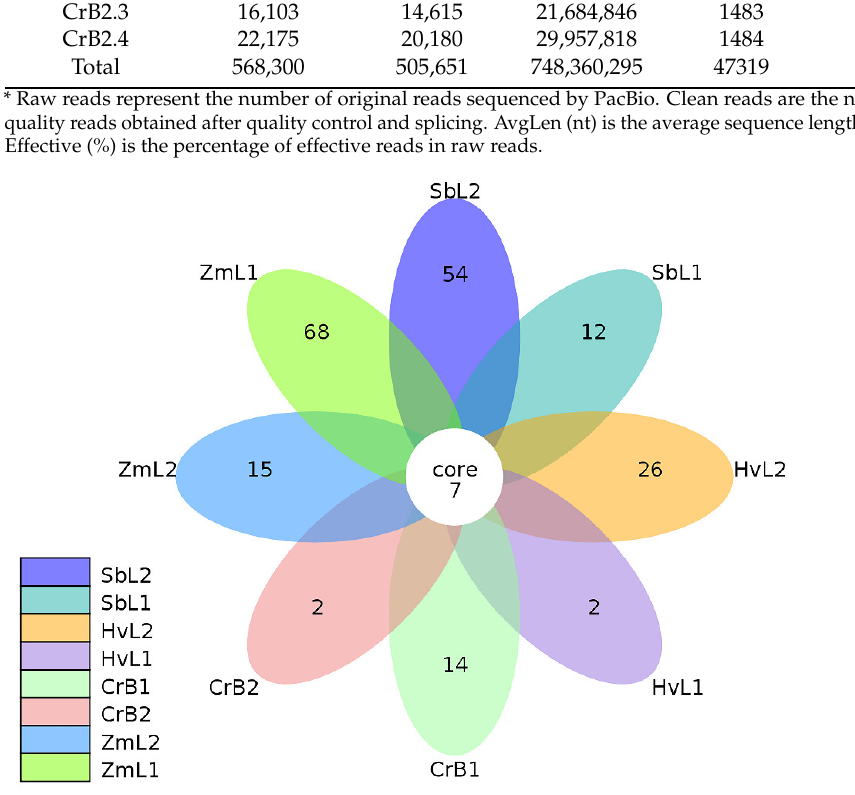
Figure 1. Flower plot of bacterial operational taxonomic units (OTUs) in guts of Spodoptera frugiperda larvae fed on leaves of different host plants. Each petal in the flower represents a treatment, and the core number in the overlapped parts of the petals represents the number of OTUs shared among treatments. The numbers at petal edges represent the number of unique OTUs in a treatment. Treatments: letters represent different host plants (Zm, corn; Sb, sorghum; Hv, highland barley; Cr, citrus), and numbers represent different larval instars (L1 or B1, fifth instar; L2 or B2, sixth